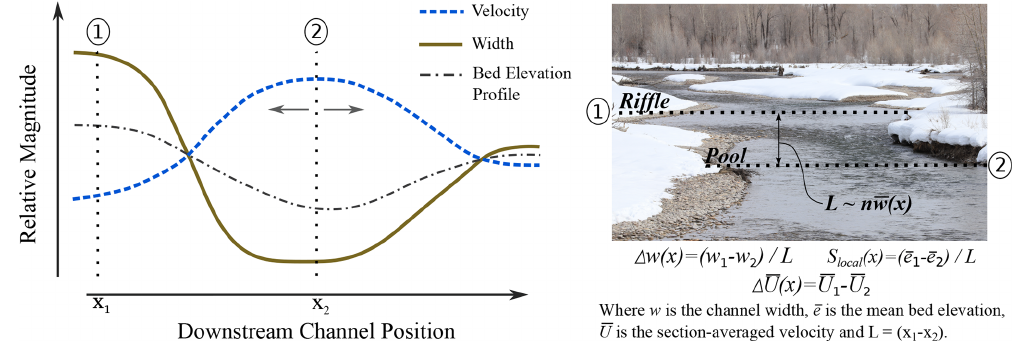
Figure 1. Conceptual diagram illustrating an inverse correlation between channel width and the width-average flow velocity (or the local shear velocity) and the likely resulting bed topography profile. The inverse correlation has been shown to occur along river segments and has been reproduced by numerical simulations of pool–riffle sequences and analogue physical experiments (Thompson et al., 1999; de Almeida and Rodríguez, 2012; Bolla Pittaluga et al., 2014; Nelson et al., 2015; Chartrand et al., 2018). The gray arrows indicate that the location of the velocity maxima (and minima) shifts depending on the flow stage (Wilkinson et al., 2004). The photograph on the right shows a gravel bed river in the spring rising snowmelt stage with a width gradient from points 1 to 2 over a distance nw ( x ), where n can vary from 1 and higher. Bed architecture at point 1 is a riffle and is a pool at point 2. Flow direction is from the top to the bottom of the image. Note the broken water surface as flow transitions into the narrower location at point 2. Photograph by Shawn M. Chartrand, Flat Creek, near Jackson Hole, WY,